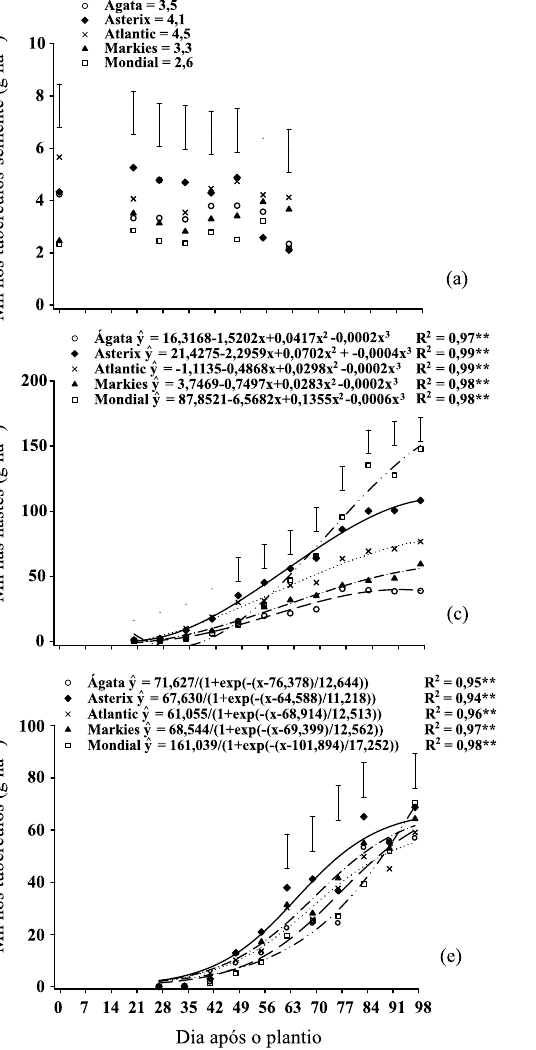
Figura 5. Quantidade de Mn nos tubérculos-semente (a), raízes (b), hastes (c), folhas (d), tubérculos (e) e na planta inteira (f) de cultivares de batata ao longo do ciclo. ** significativo a 1 % pelo teste F. Barras verticais indicam o valor de DMS pelo teste de Tukey a 5